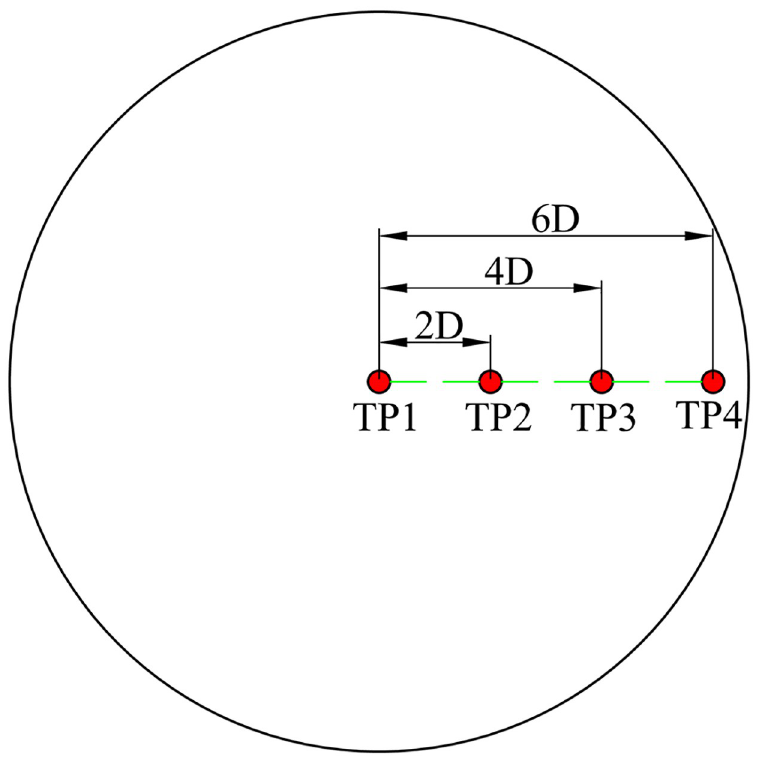
Fig 4. Arrangement of test points in the